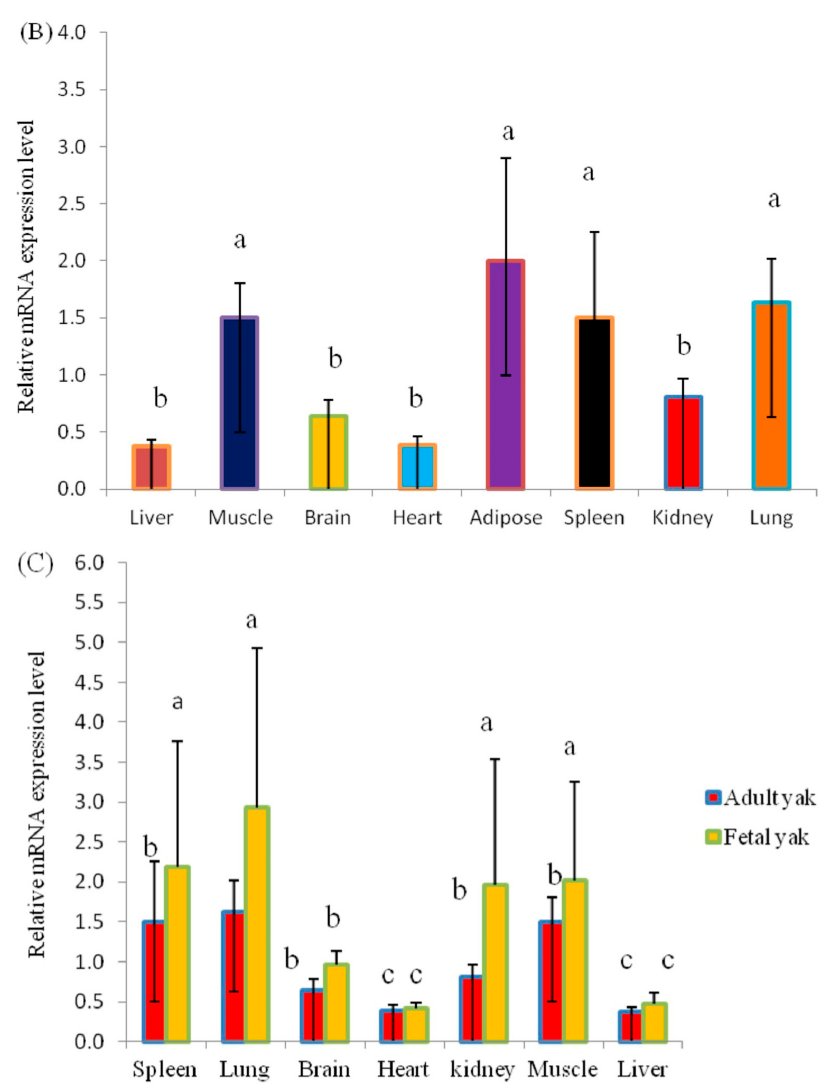
Figure 2. Expression profiles of the KLF6 gene in Datong yak at two ages. ( A ) Expression pattern of the KLF6 gene in fetal yak. ( B ) Expression pattern of the KLF6 gene in adult yak. ( C ) Comparison of KLF6 gene expression between the two ages. The error bars indicate the standard deviations (SDs). Different letters indicate significant differences ( p < 0.05).